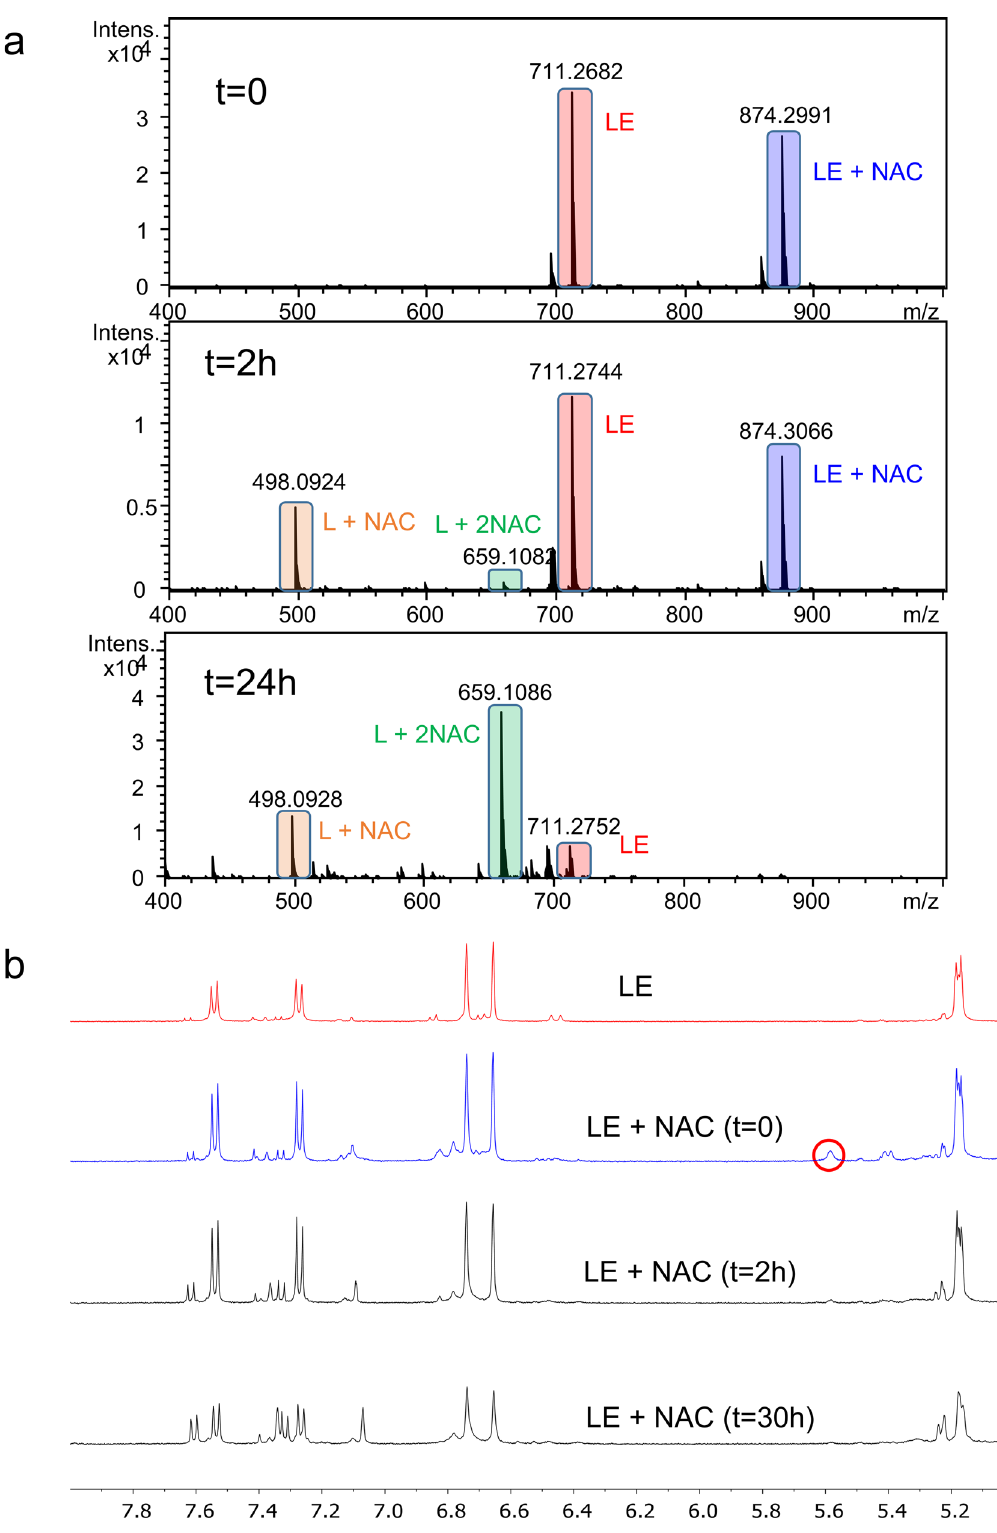
Fig. 3 Mass spectrometry and NMR studies of LE and NAC interaction. a Time-dependent ESI – TOF mass spectra of LE (0.2 mM) mixed with NAC (0.4 mM) in H 2 O with 20% MeOH. The peaks corresponding to the different species are highlighted with boxes of different colors: LE (red box), LE + NAC (blue box), L + NAC (orange box), and L + 2NAC (green box). b 1 H-NMR in CD 3 OD of LE (7 mM, in red) and of LE (7 mM) mixed with NAC (10 mM) at different time points as indicated in the